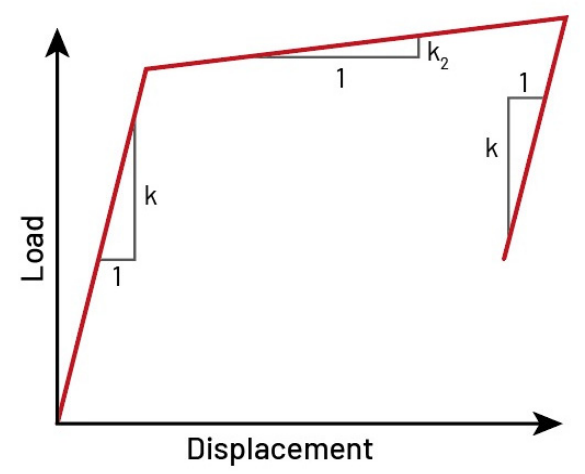
Figure 3. Uniaxial plasticity properties of bracing (Adapted with permission from [5]).